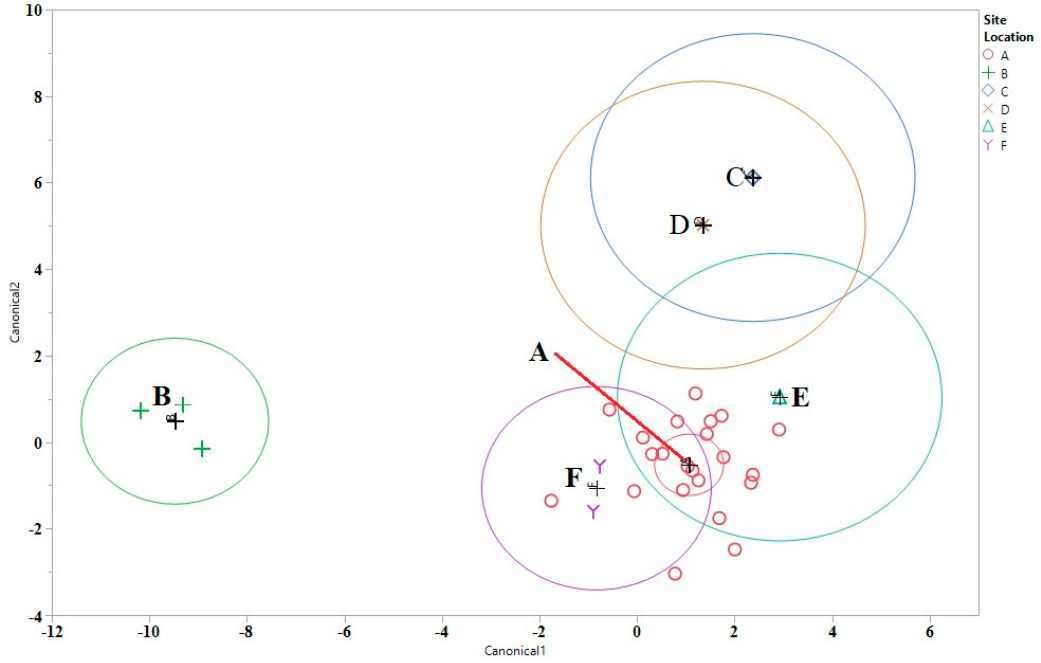
Figure 7. LDA plot of data.